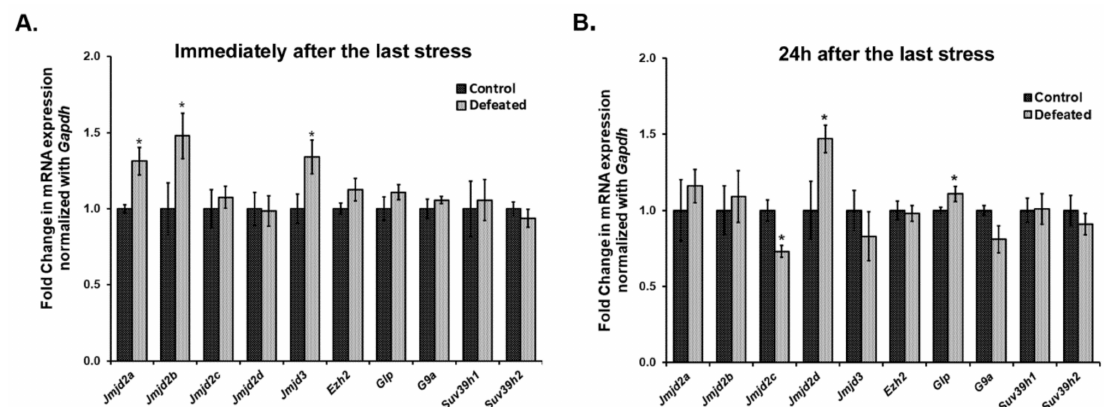
Figure 3. Ten days of CSDS causes dysregulation in the mRNA expression of a few of the histone lysine methylases and demethylases. mRNA expression levels of methylases and Jmjd2 / Jmjd3 family demethylases were analysed in the DG of the mice at both the time point using qPCR. ( A ) Two members of the Jmjd2 family, Jmjd2a , and Jmjd2b along with Jmjd3 exhibit a significantly higher mRNA